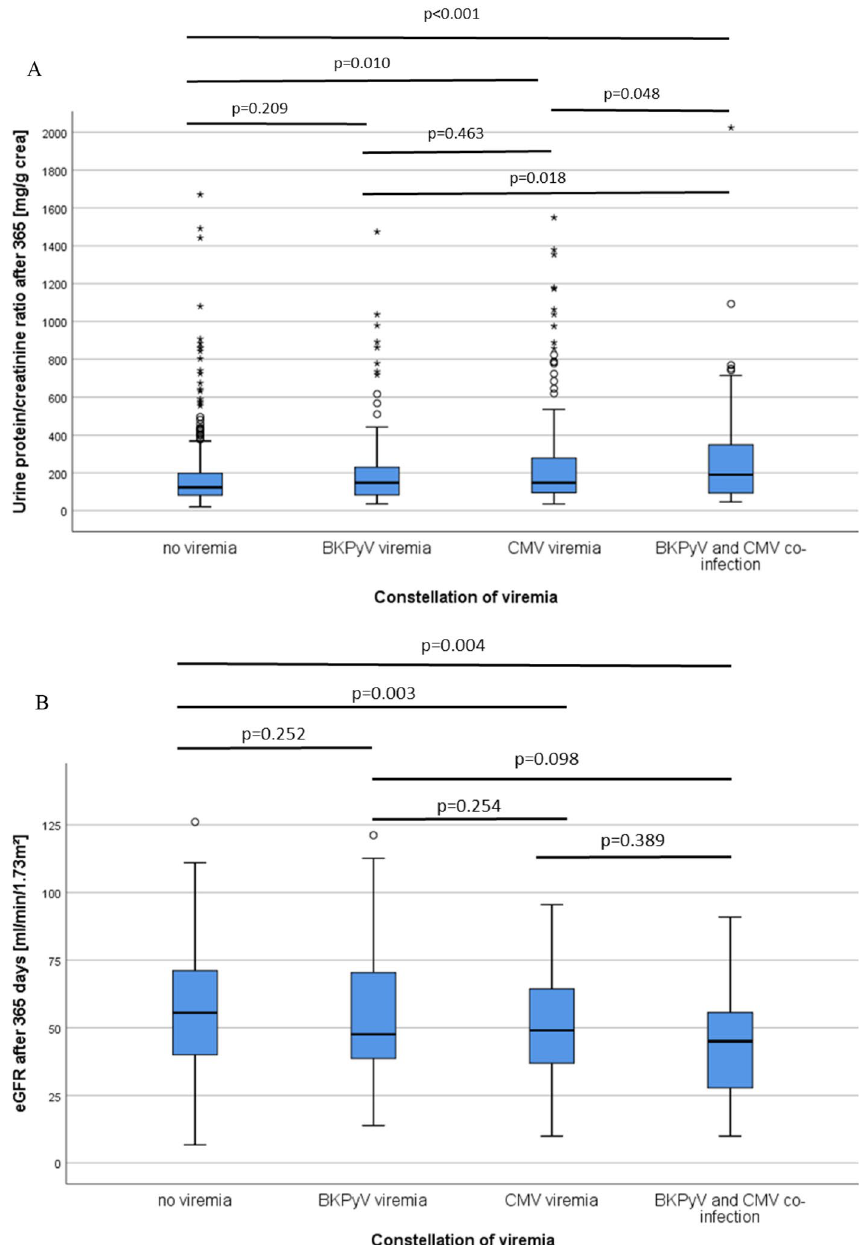
Figure 4. Transplant recipients who developed co-infection with BKPyV and CMV showed lower eGFR compared to recipients with isolated CMV or BKPyV DNAemia after 1 year ( A ) and also higher proteinuria ( B ). Patients without any viremia showed the highest eGFR levels and lowest